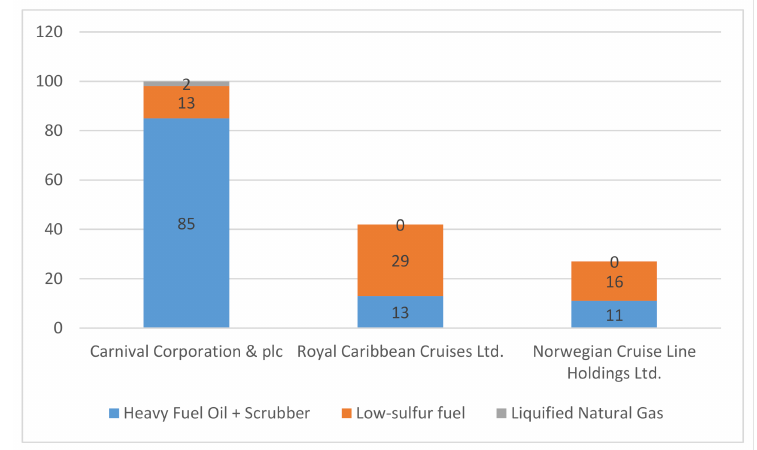
Figure 1. Cruise line fuel choices for cruise ships [13].